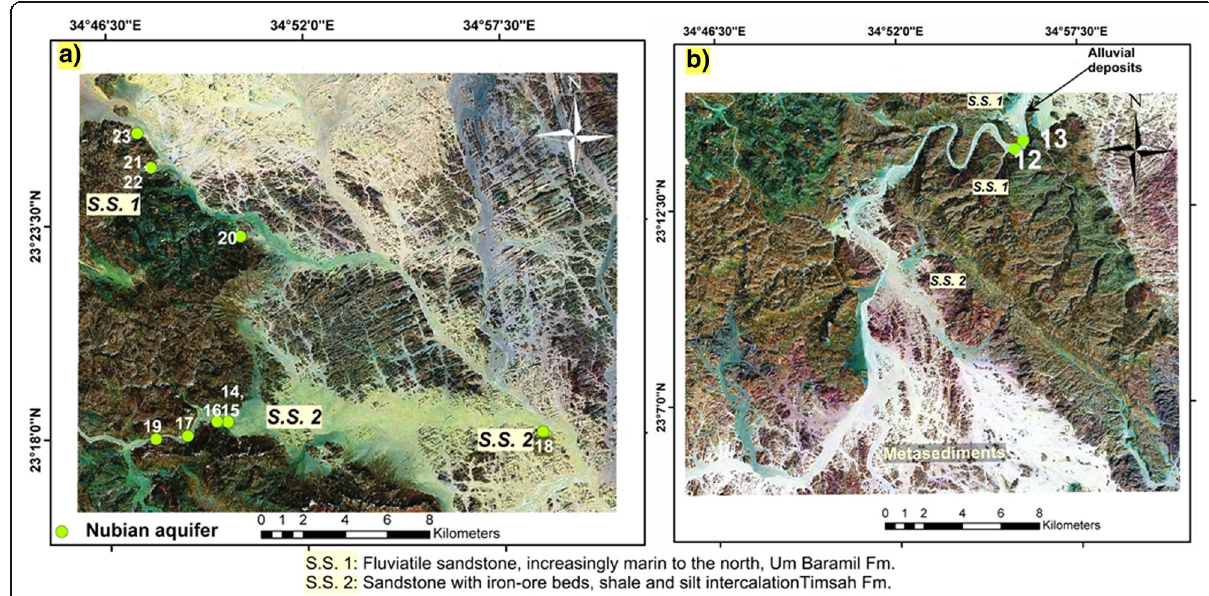
Fig. 5 Location map of Nubian Sandstone Aquifer illustrated on Landsat images (GeoCover ETM+2010) where the recorded wells are effected by two formations: Um Baramil and Timsah. These two formations are representing the water-bearing formation and also the geology along the flow path to this